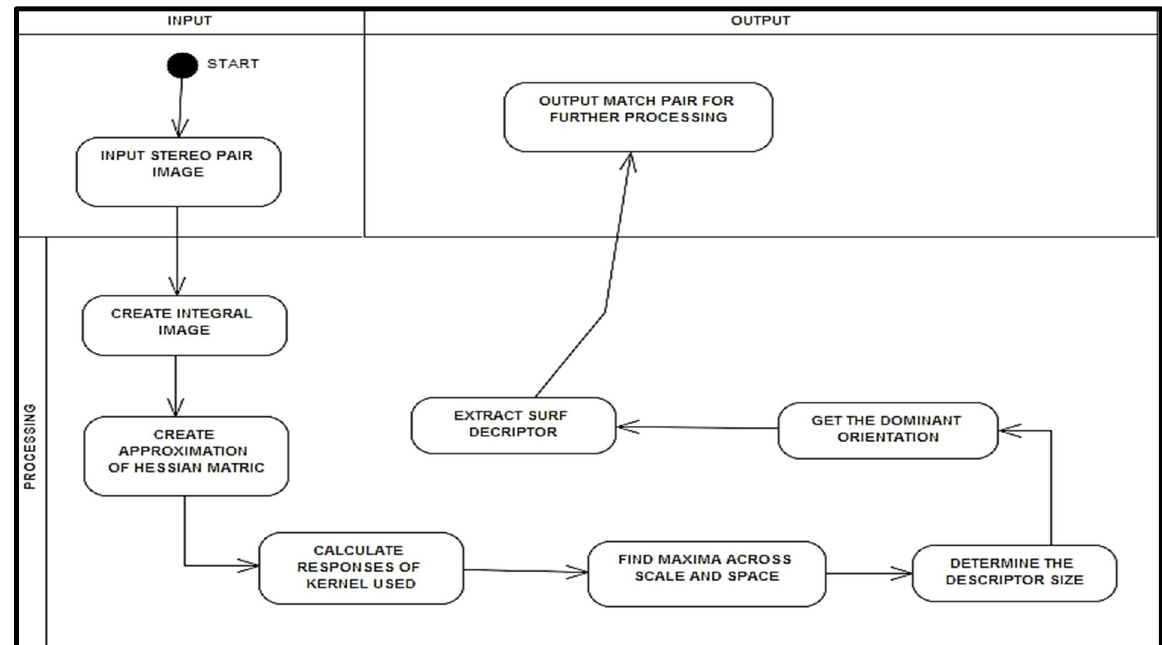
Figure 3: Activity diagram for Speeded Up Robust Feature (SURF) detector